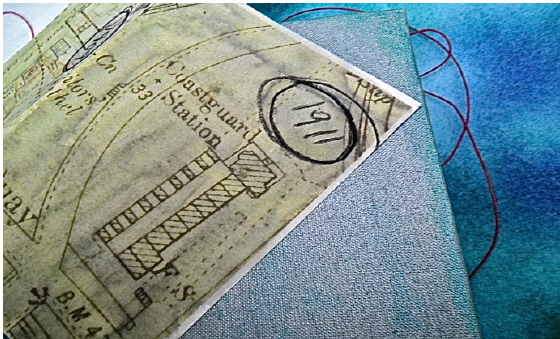
Figure 7. Map fragment, 2015 [1911]. © Silvia Loeffler, Glas Journal,